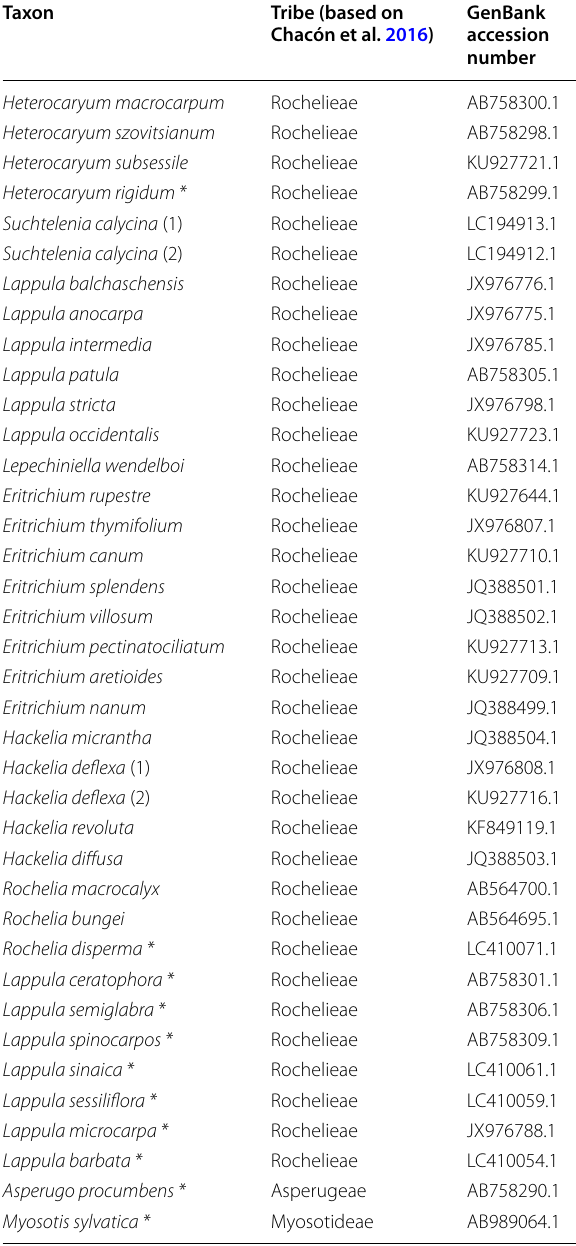
Table 3 List of taxa used in phylogenetic analysis with